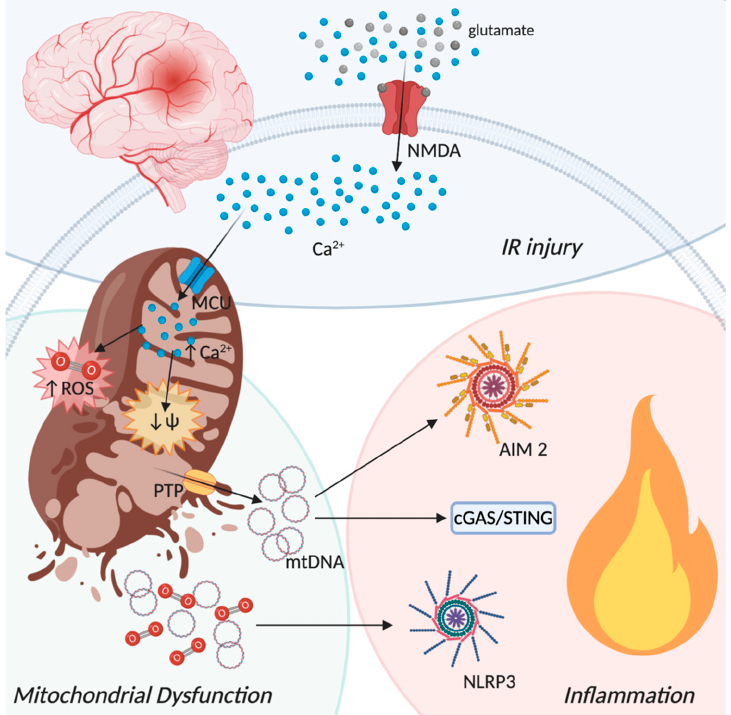
Figure 3. Ischemic-reperfusion injury from a mitochondrial perspective. Oxygen depletion occurring during an ischemic event lead to neuronal membrane depolarization with glutamate release in the extracellular space. Glutamate binds to N-methyl-D-aspartate (NMDA) receptors promoting a strong influx of Ca 2+ . The increase of cytosolic Ca 2+ activates the mitochondria calcium uniporter (MCU) leading to mitochondrial depolarization and increased production of reactive oxygen species (ROS) with the consequent opening of the permeability transition pore (PTP) and the final disruption of the mitochondrial membranes. mtDNA and ROS release in the cytoplasm drives the inflammatory process by the activation different pathways, such as AIM2 and the NLRP3 inflammasomes and the cGAS-STING dsDNA sensing machinery. Created with BioRender.com.